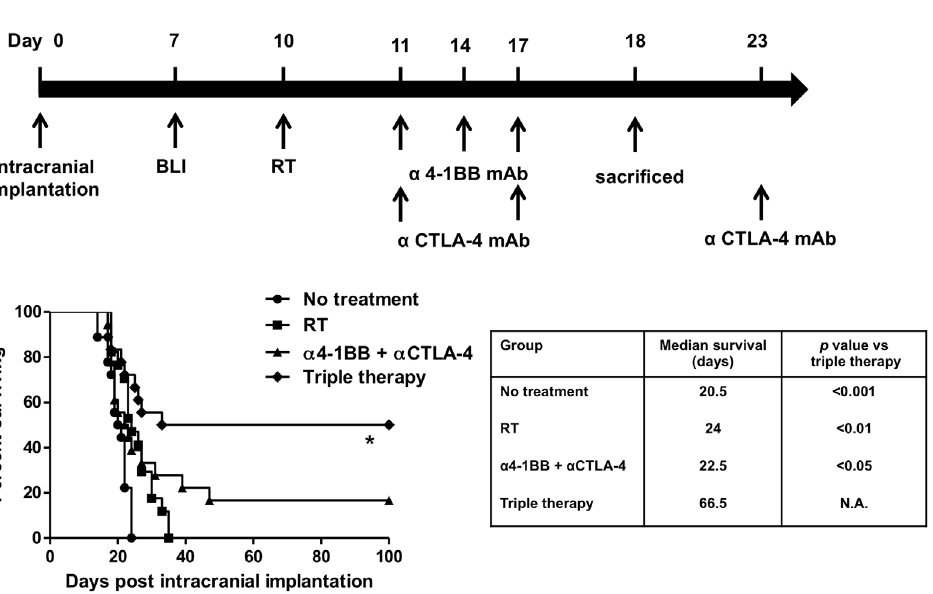
Figure 3. Combining focal radiation therapy with anti-4-1BB and anti-CTLA-4 antibodies results in long-term survival. A) Schematic of the treatment protocol for triple therapy. B) Kaplan Meier survival curves for double immunotherapy and triple therapy ( n =18/group). Treatment with triple therapy was superior to double immunotherapy with anti-4-1BB and anti-CTLA-4 antibodies ( p , 0.05), focal RT alone ( p , 0.01) and untreated mice ( p , 0.001). Furthermore, triple therapy results in long-term survival in at least 50% of treated animals, whereas immunotherapy with both 4-1BB activation and CTLA-4 blockade produced long-term survival in 3/18 mice (16.7%). Data from three repeated experiments with similar results was pooled into single Kaplan Meier curves. P values were calculated with the Log-Rank test.